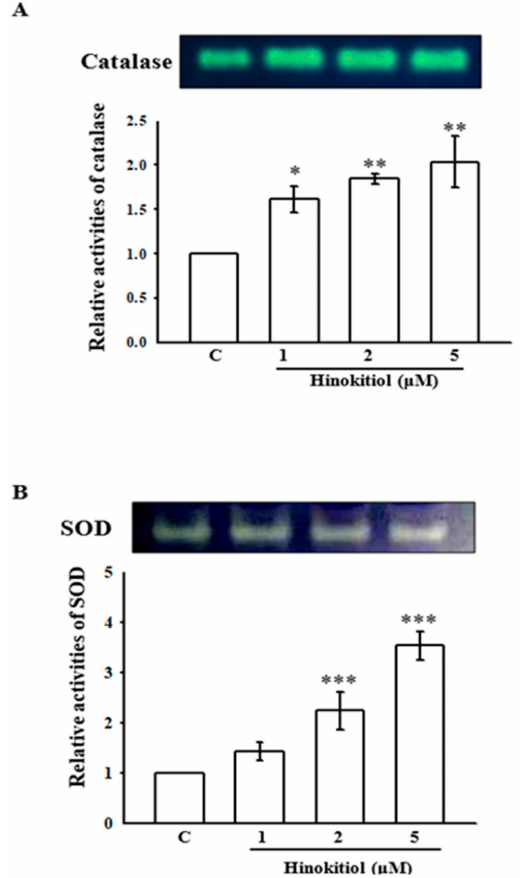
Figure 5. Effects of hinokitiol on catalase (CAT) and superoxide dismutase (SOD) activity in A549 cell line. A549 cells were treated with different concentrations of hinokitiol (1–5 µ M) in serum-free media for 24 h. Cell lysates were obtained for the assay of CAT ( A ) and SOD ( B ) activities by using native-PAGE. The figures are representative examples of three independent experiments. * p < 0.05, ** p < 0.01, and *** p < 0.001 compared with untreated A549